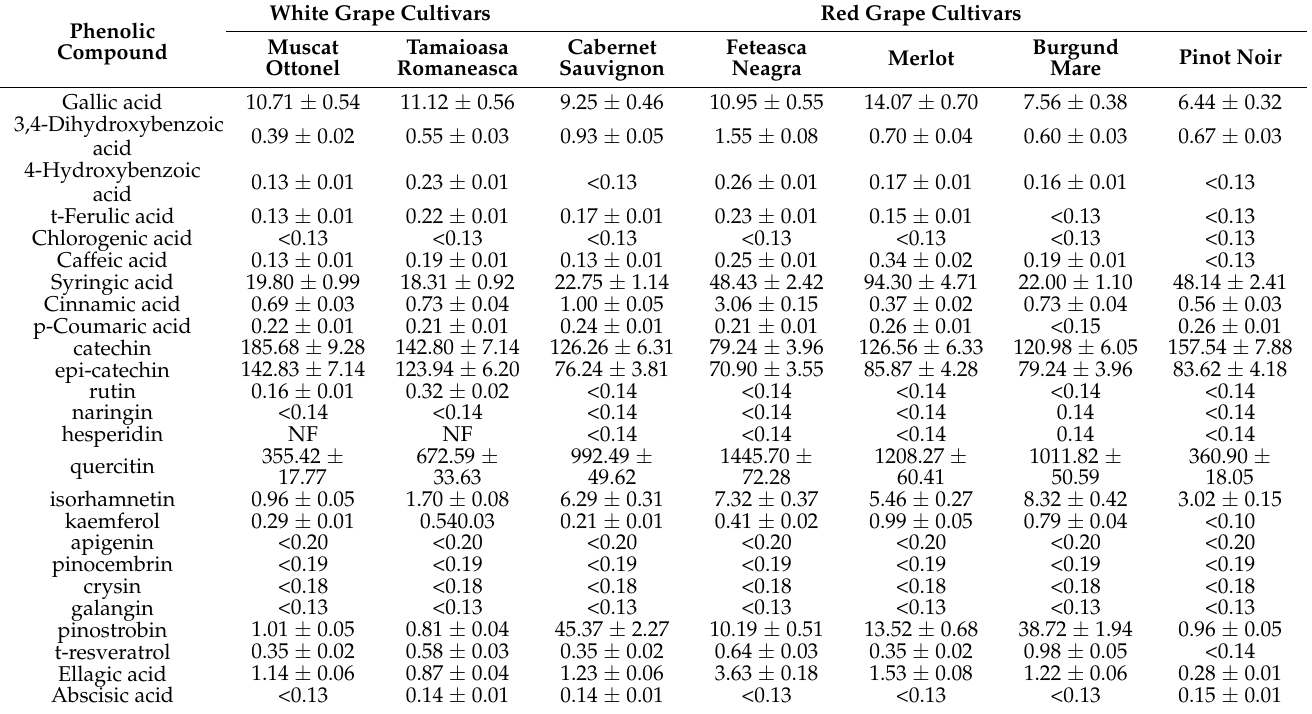
Table 3. Concentration of phenolic compounds in different grape pomaces (mg/100 g DW).